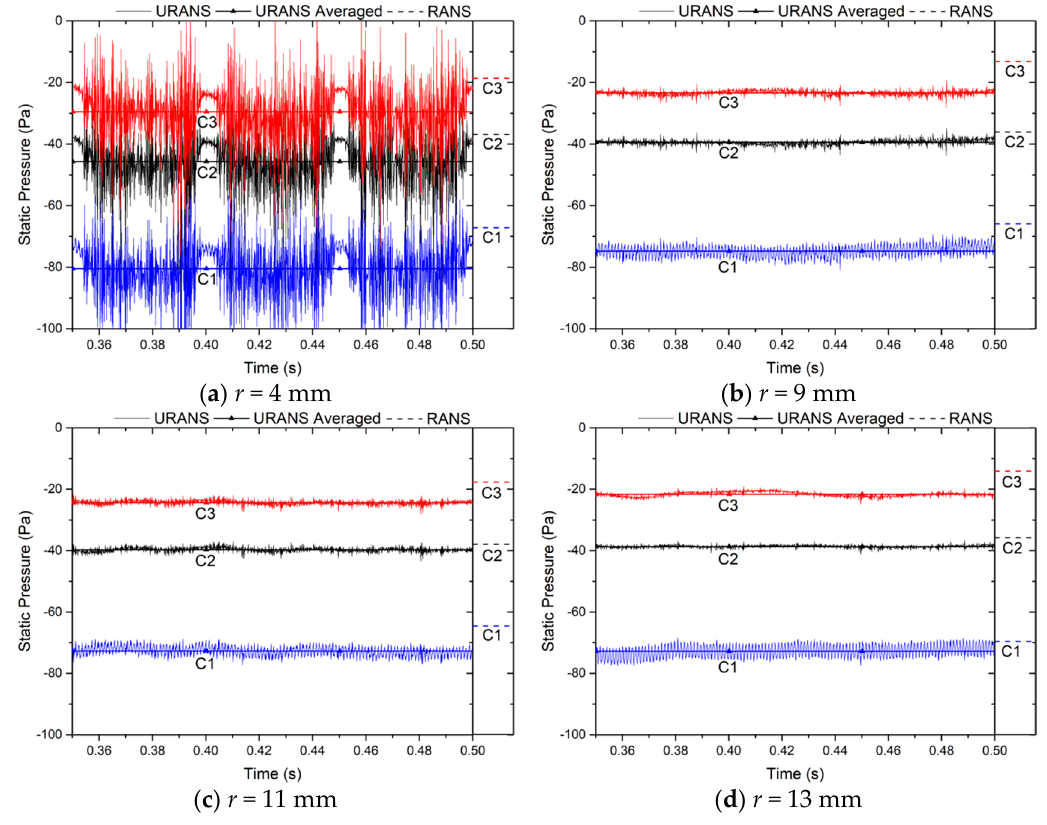
Figure 20. Static pressure fluctuation at monitors C1/C2/C3.